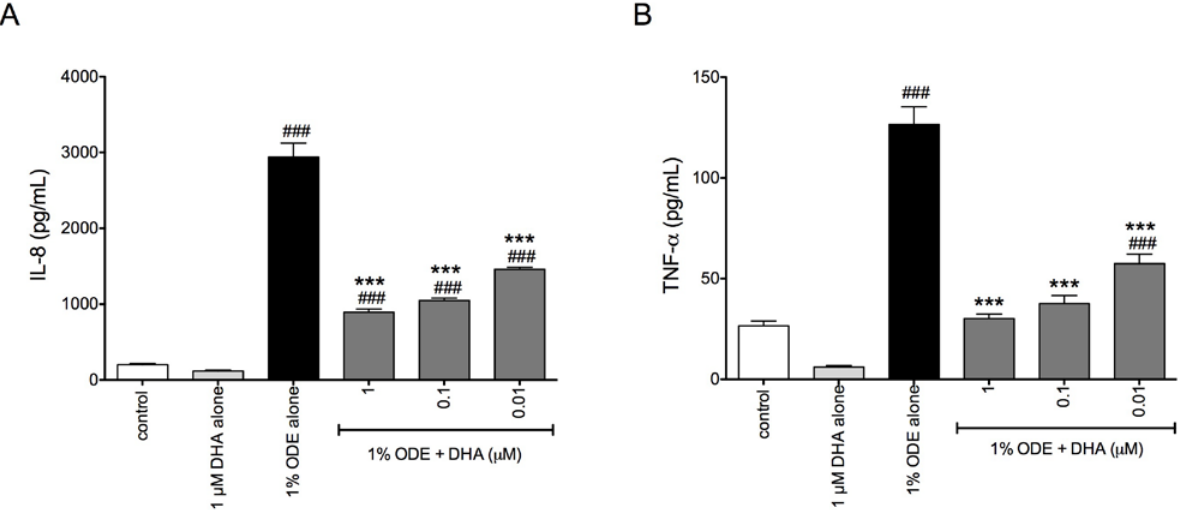
Figure 2. DHA pretreatment reduces ODE-stimulated IL-8 and TNF-α release in monocytes. THP-1 cells were pretreated for 1 h with 0, 0.01, 0.1, or 1 μM DHA prior to stimulation with 1% ODE. At 24 h after ODE treatment, cell supernates were collected and IL-8 ( A ) and TNF-α release ( B ) were measured via ELISA. ### p ≤ 0.001 vs. control; *** p ≤ 0.001 vs. 5% ODE